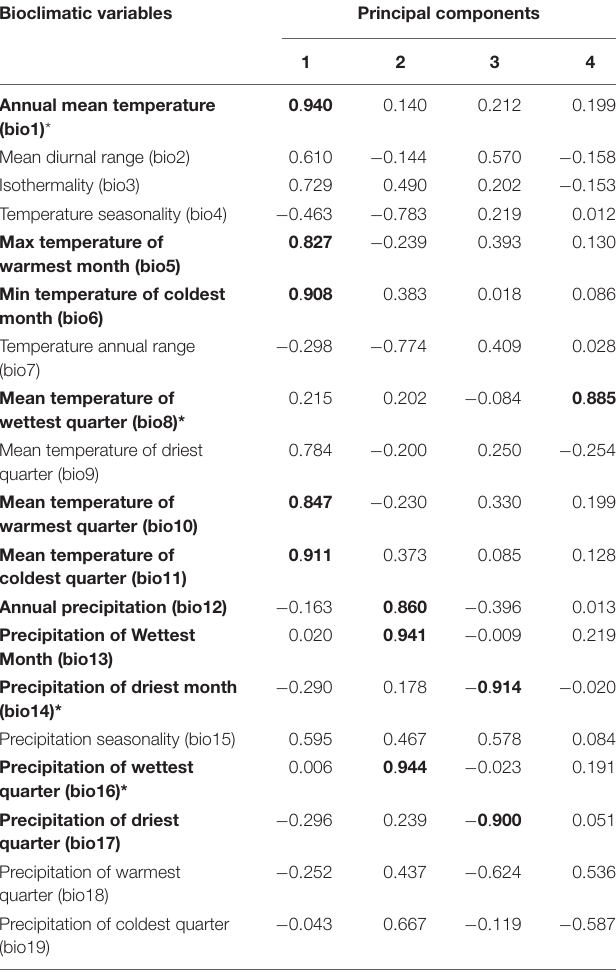
TABLE 1 | Principal component analysis (PCA) performed on 19 bioclimatic variables to model distribution of Carpomya pardalina. Bioclimatic